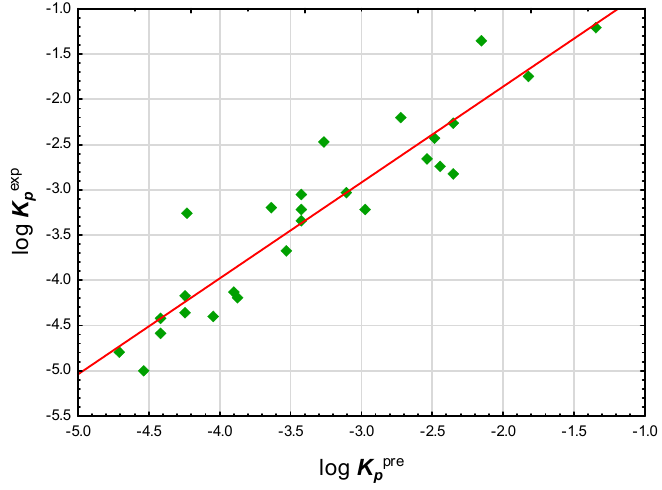
Figure 3. log K p experimental values vs. preADMET, compounds 1 to 27 .